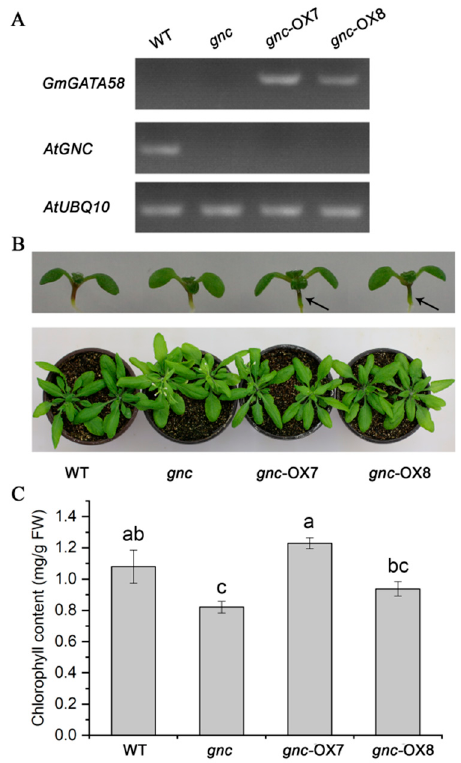
Figure 4. Genetical complementation of GmGATA58 gene in the Arabidopsis gnc mutant. ( A ) Semi-quantitative RT-PCR assay of GmGATA58 and AtGNC gene in the 3-week-old rosette leaves of wild-type (WT), gnc mutant, and two T 3 transgenic lines overexpressing GmGATA58 in the gnc mutant background ( gnc -OX7 and gnc -OX8). The AtUBQ10 gene was used as an internal control. ( B ) Phenotypic comparison of wild-type, gnc mutant, and two transgenic lines at one week (upper panel) and four weeks (bottom panel) after germination. Arrows indicated dark green hypocotyls. ( C ) The chlorophyll content measurement in the rosette leaves of wild-type, gnc mutant and two transgenic lines at three weeks after germination. Data are presented as mean ± SD ( n = 10) from three independent measurements. Means not sharing any lowercase letter are significantly different by the Tukey test at the 5% level of significance.